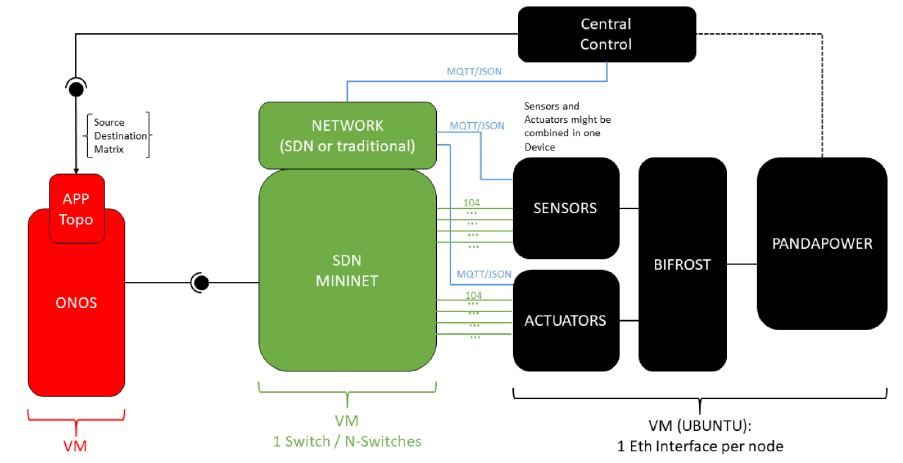
Figure 5. Lab C Virtual Machine Setup.